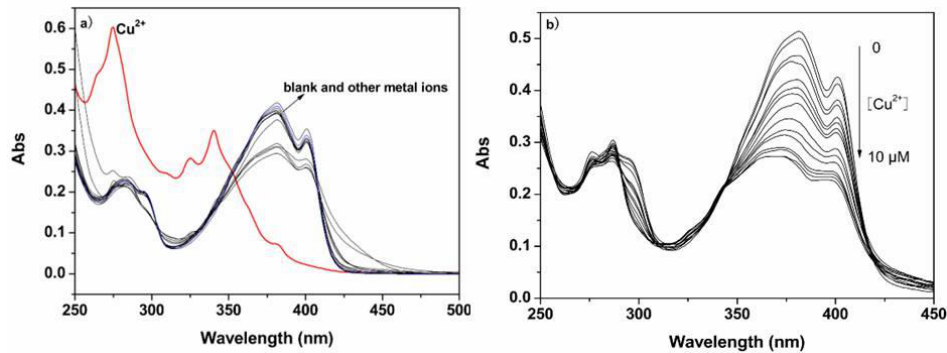
Figure 2. Absorption spectra . a ) absorption spectra of P (10 μM) toward metal ions ( 100 μM ) in al- cohol – aqueous media ( v / v , 8:2, pH 6.3, 0.02 M HEPES); b ) absorption titration of P (10 μM) upon addition of increasing amounts of Cu 2+ (0 –10 μM) under the same conditions.